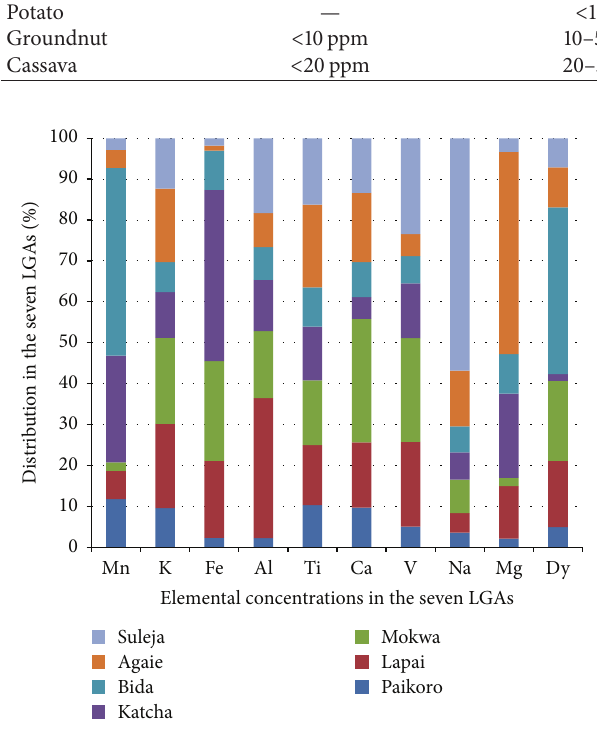
Figure 2: Elemental concentration of soil samples obtained in seven local government areas in niger